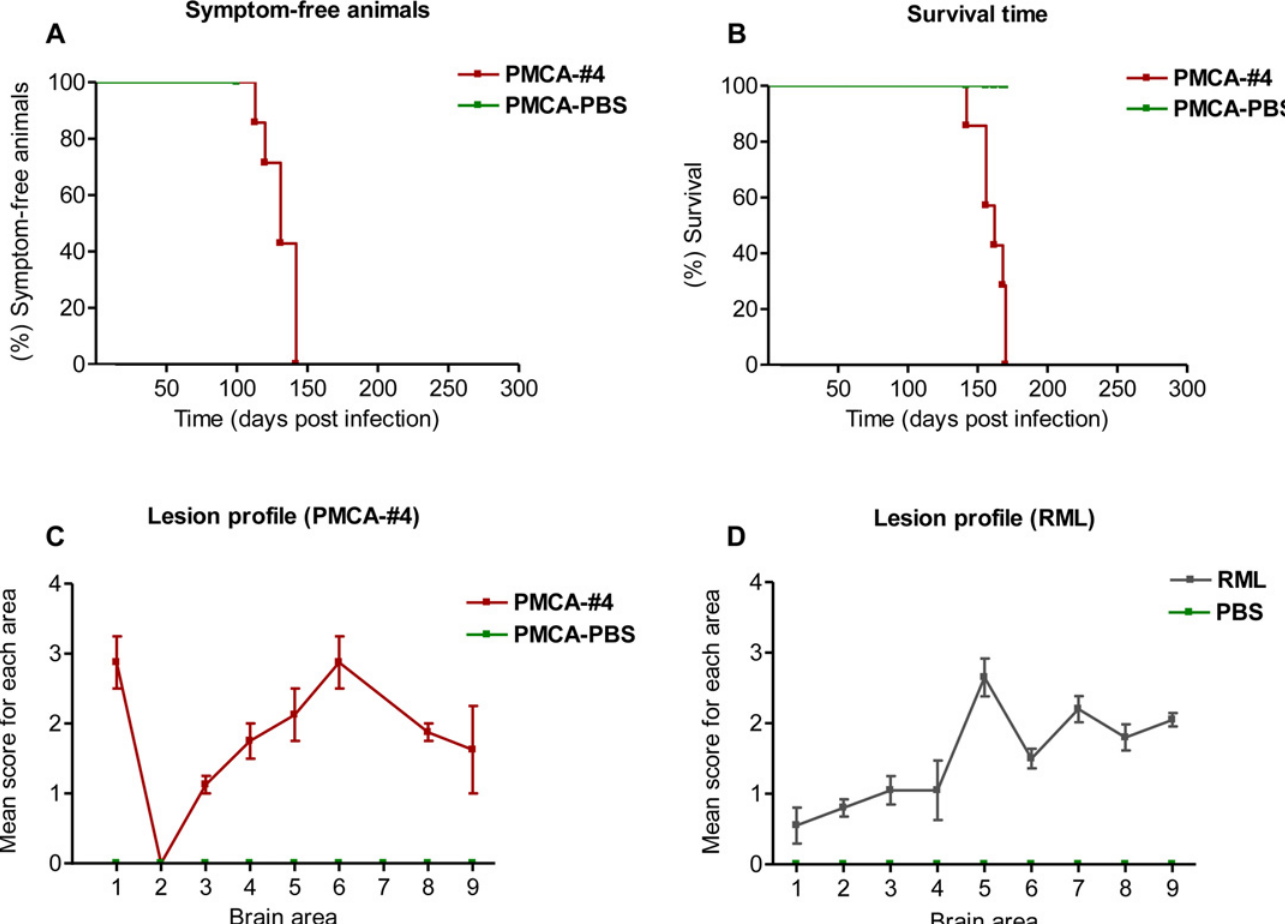
Fig 9. Incubation time, survival time and lesion profile analysis of PMCA-#4 infected animals. The animals injected with PMCA-#4 showed an incubation (A) and survival time (B) of 130 ± 4.4 and 160 ± 3.85 days (Mean ± Standard Error of the Mean, SEM) and results were analyzed with the Logrank test. Spongiform profiles were determined on Hematoxylin and Eosin (H&E)-stained sections, by scoring the vacuolar changes in nine standard gray matter areas: 1. Dorsal medulla; 2. Cerebellar cortex; 3. Superior culliculus; 4. Hypothalamus; 5. Thalamus; 6. Hippocampus; 7. Septum; 8. Retrosplenial and adjacent motor cortex; 9. Cingulated and adjacent motor cortex, as described by Fraser et al. [54]. Lesion profile was compared to that of RML (i.c.) infected animals. Bars in C and D indicate Standard Error of the